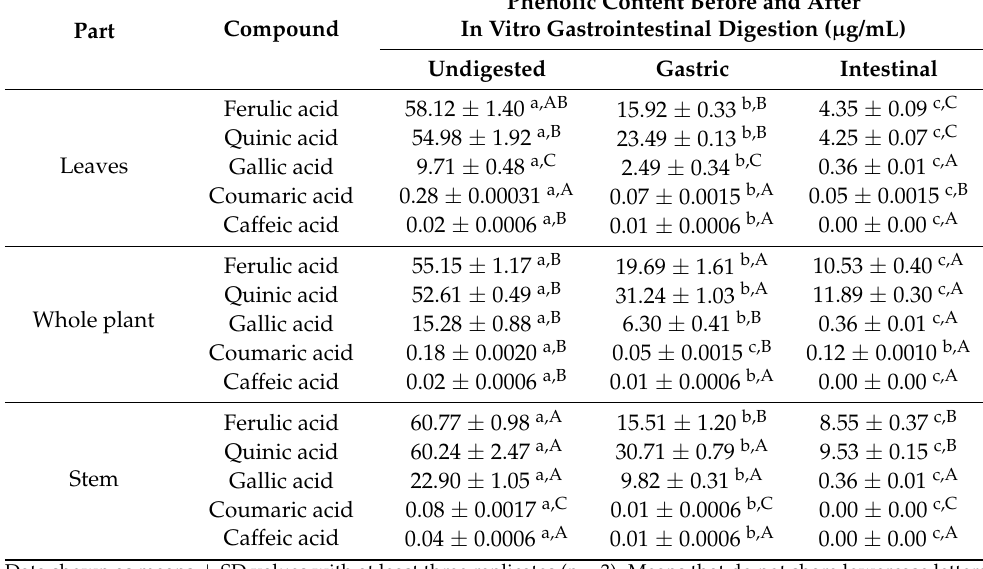
Table 1. Quantification and bioaccessibility of phenolic acids by UPLC-MS in mistletoe infusions before and after gastrointestinal in vitro digestion. Phenolic Content Before and After In Vitro Gastrointestinal Digestion ( µ g/mL) Part Compound Undigested